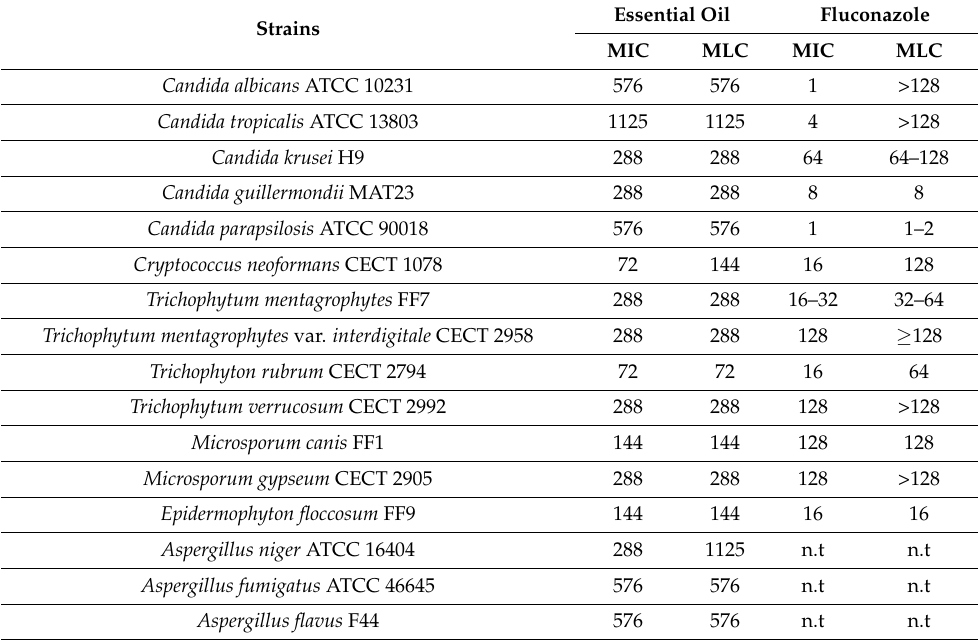
Table 2. Antifungal activity of Bupleurum rigidum subsp. paniculatum essential